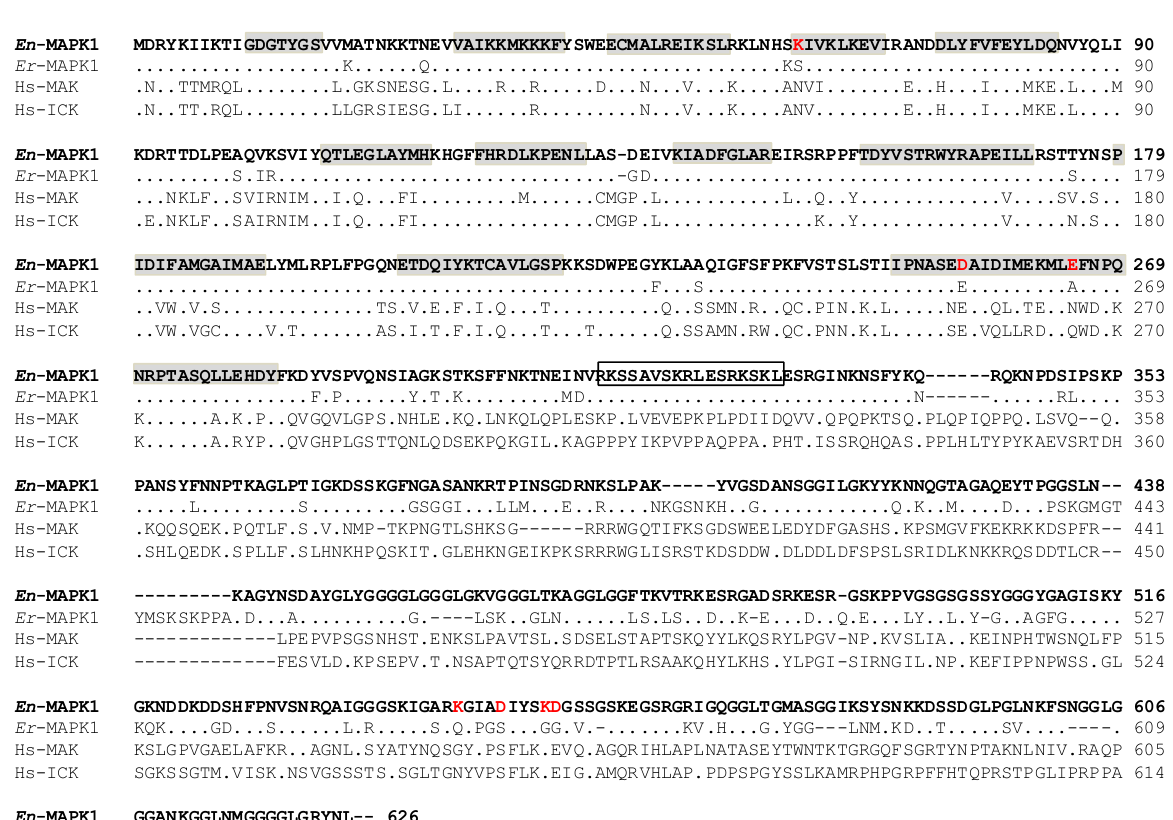
Figure 3. Amino acid sequence alignment of En- MAPK1 (in bold) with Er- MAPK1 (AM409185) and human MAK (NP_005897) and ICK (NP_055735). The alignment was maximized by gap insertions and dots indicate identical residues. In En- MAPK1 sequence, the catalytic sub-domains are highlighted in gray, while the amino acid substitutions internal to these sub-domains and within the carboxy-terminal tail are marked in red. The putative nuclear localization signal is